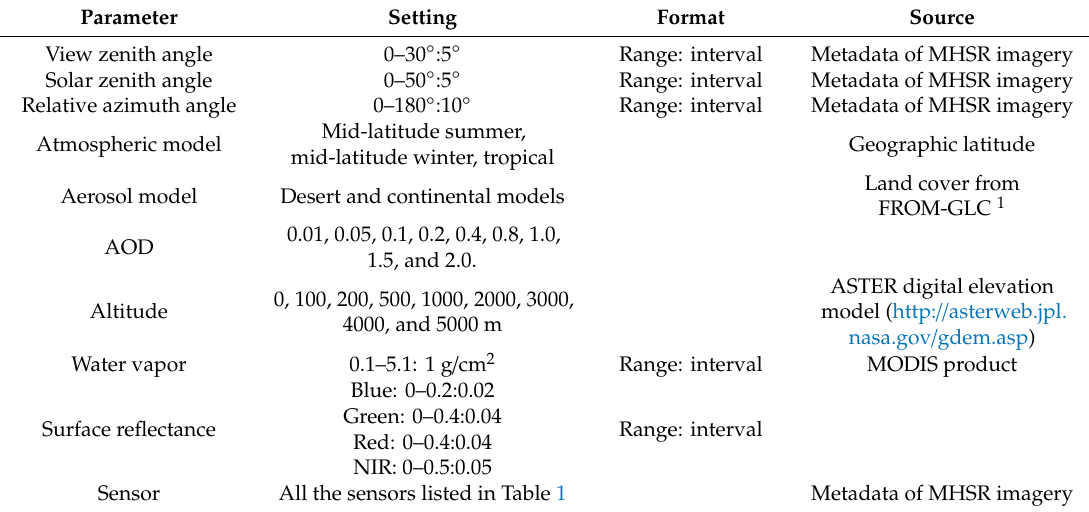
Table 3. The settings of 6S’s parameters to create look-up tables (LUTs) for AOD retrieval and atmospheric